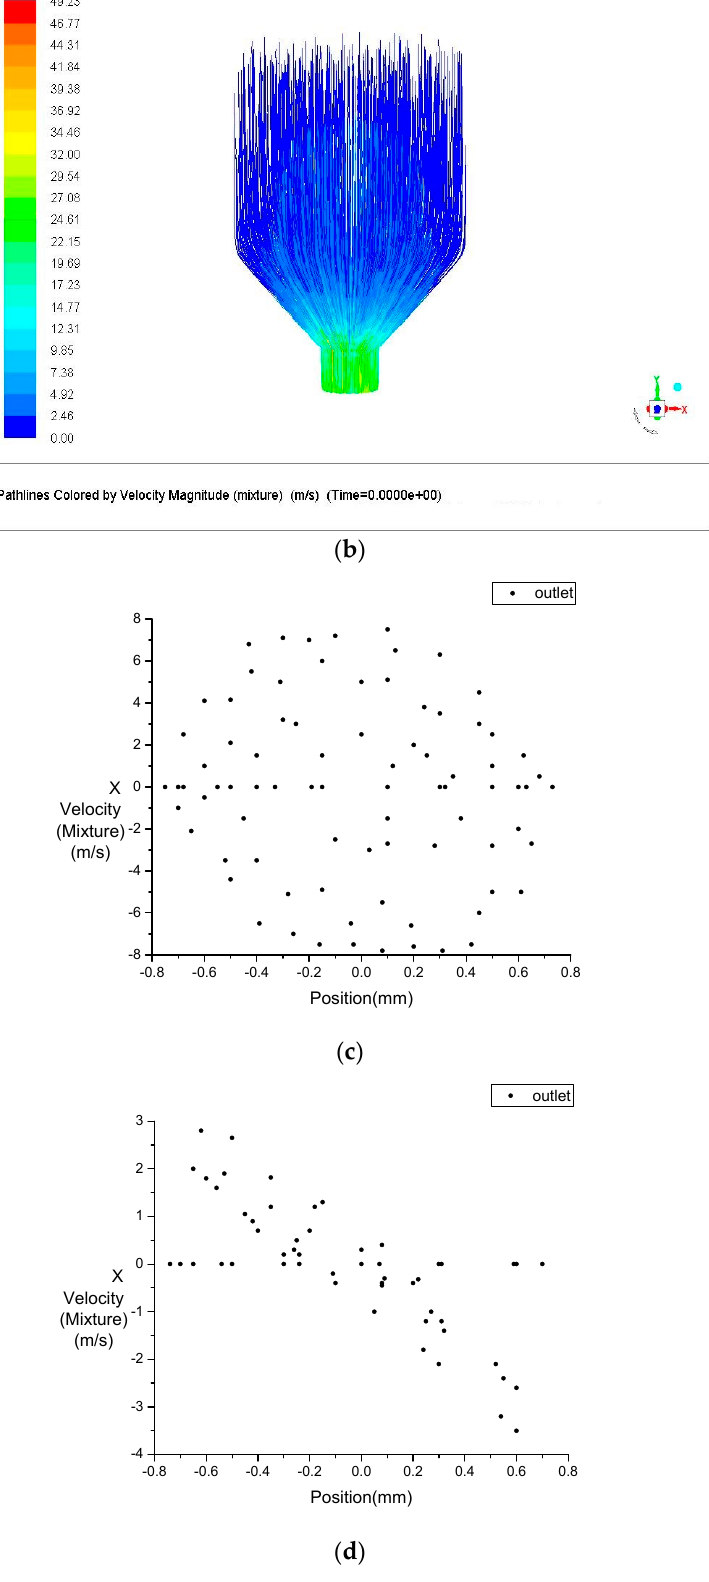
Figure 5. Results of numerical simulations of two types of nozzles: ( a ) the swirl nozzle mass flow path line, ( b ) the traditional nozzle mass flow path line, ( c ) the X-velocity on the swirl nozzle outlet face, and ( d ) the X-velocity on the traditional nozzle outlet face.